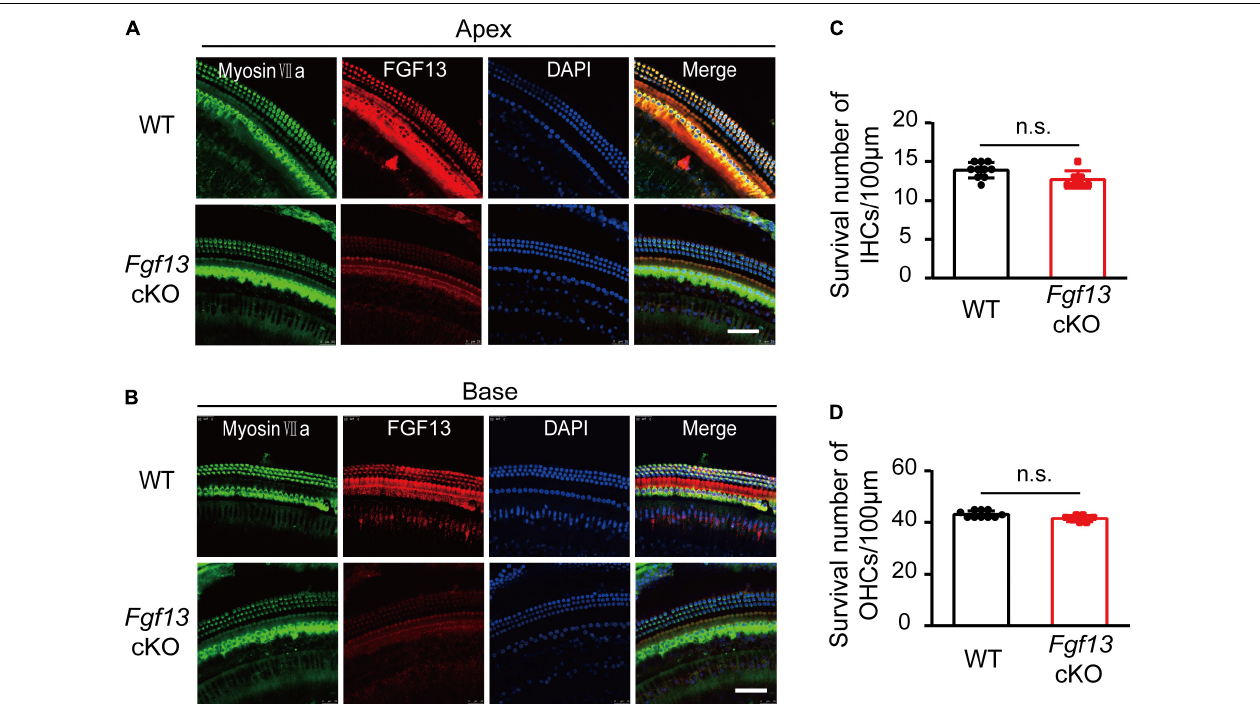
FIGURE 6 | Fgf13 cKO unalters the morphology and densities of HCs. (A,B) Confocal whole-mount images of cochlea HCs in WT and Fgf13 cKO mice form the apex (A) to the base (B) . (C,D) Quantitative analysis of the survived inner HCs (C) and outer HCs (D) . There are no obvious abnormalities of morphology (A,B) and densities (C,D) for both inner HCs and outer HCs in Fgf13 cKO mice. n = 10/WT (7 males, 3 females); n = 7/ Fgf13 cKO (4 males, 3 females). n.s., no significance. Scale bar = 50 µ m; P > 0.05 as determined by One-Way